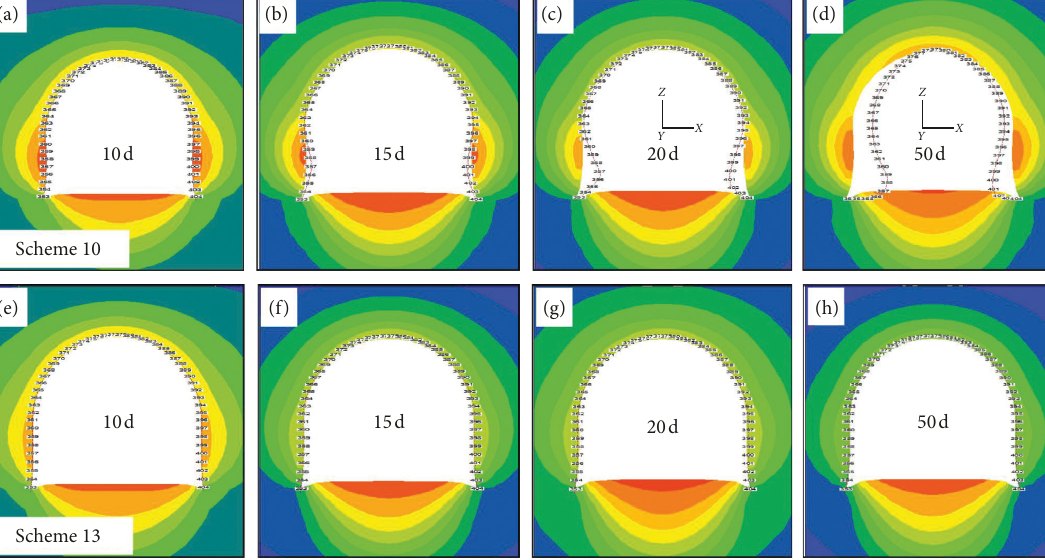
Figure 13: Deformations of the roadways and the supporting arches. (a)–(d): Scheme 10 at the 10 th day, 15 th day, 20 th day, and the 50 th day; (e)–(h): Scheme 13 at the 10 th day, 15 th day, 20 th day, and the 50 th